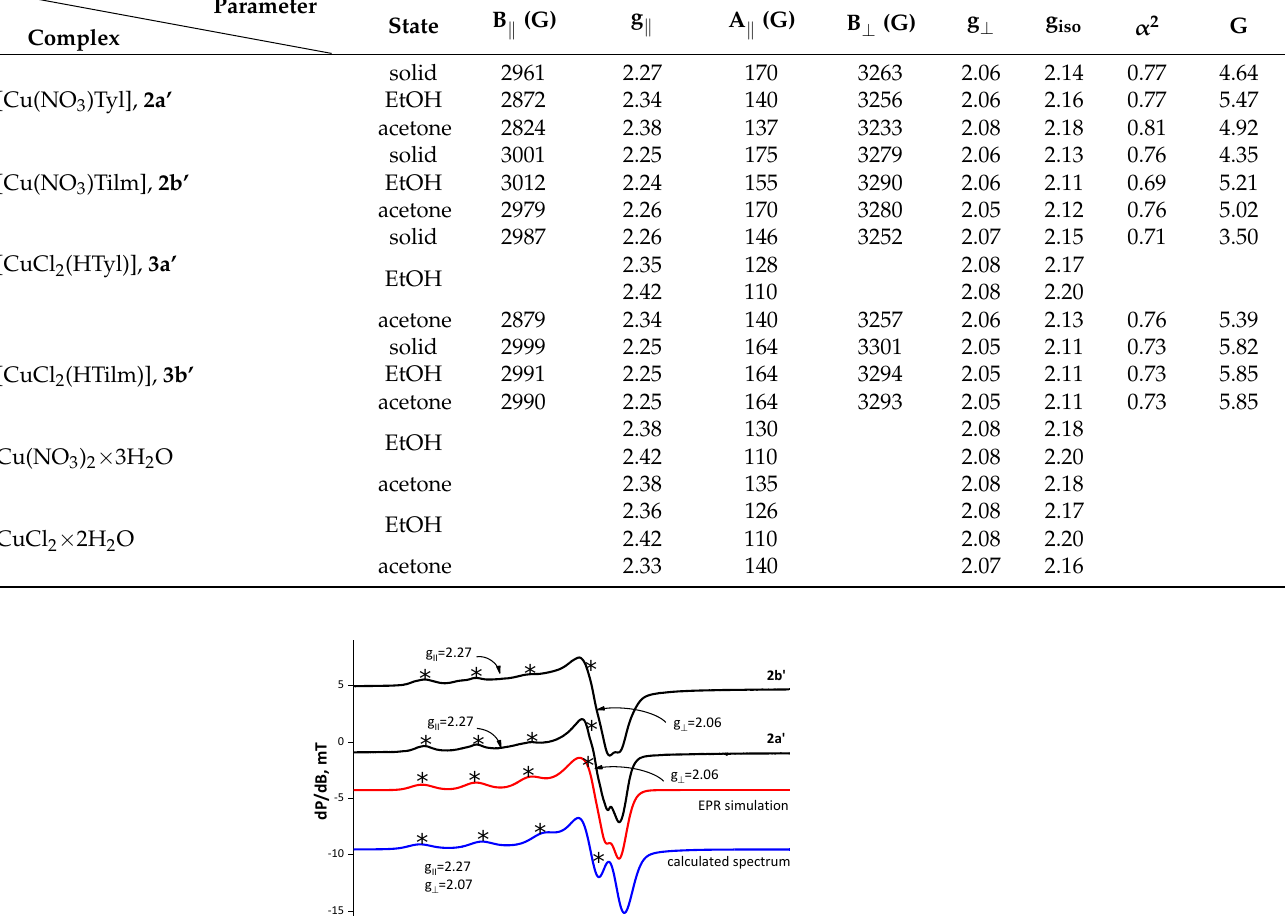
Table 3. X-band EPR parameters of copper(II) complexes 2a’ – b’ and 3a’ – b’ and copper(II) salts.